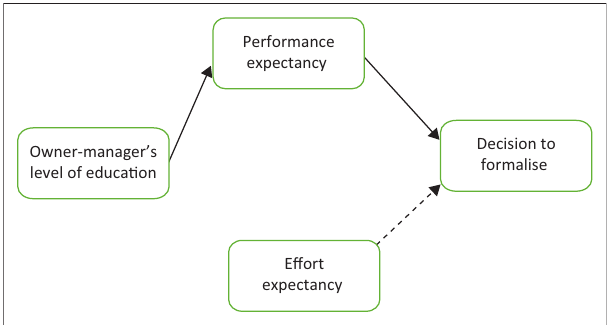
FIGURE 4: Personal factors affecting human resource formalisation in family-owned accommodation small and medium-sized enterprises.